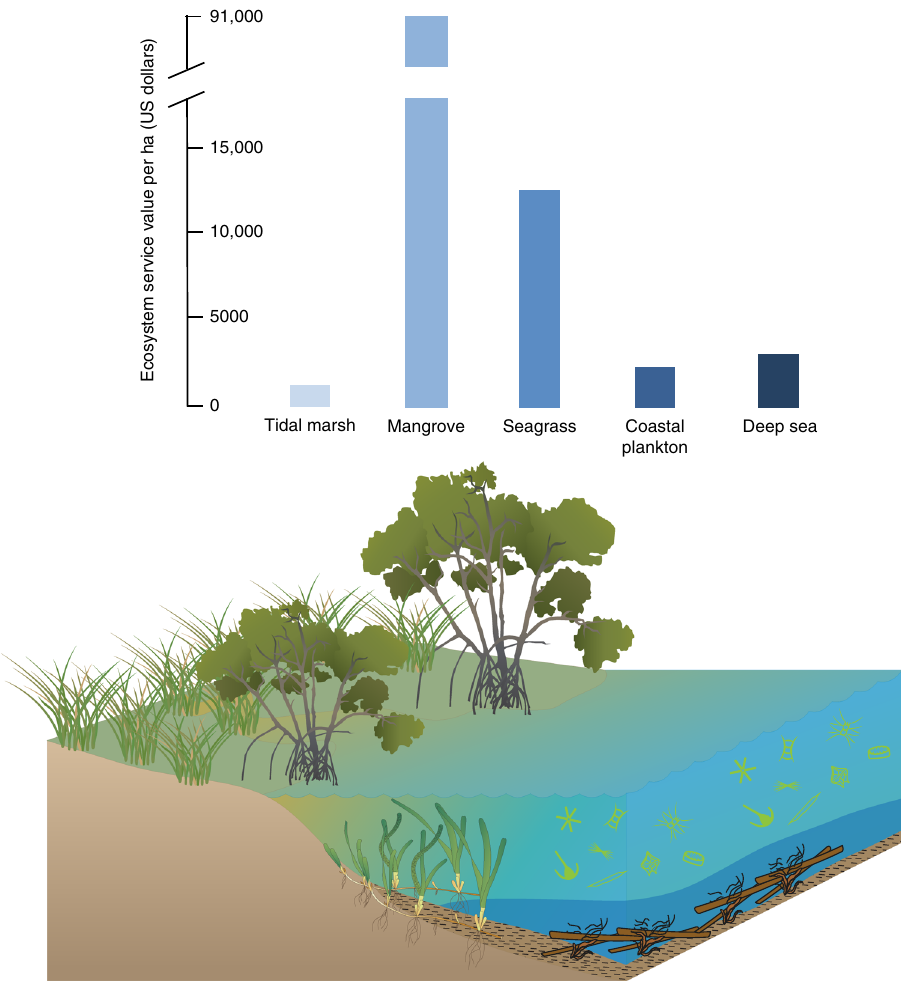
Fig. 2 Estimates of the economic value of blue carbon ecosystems per hectare. Data from ref. 1 and references therein. Symbols and images are courtesy of the Integration and Application Network, University of Maryland Center for Environmental Science